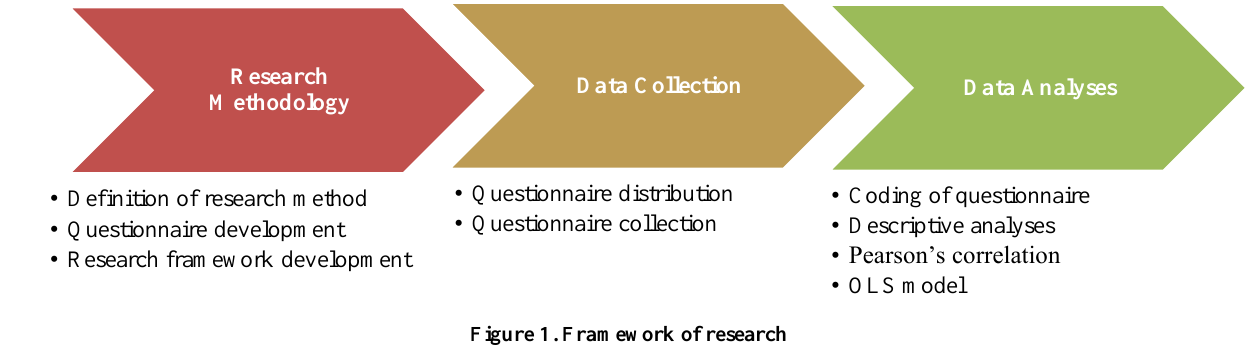
Figure 1. Framework of